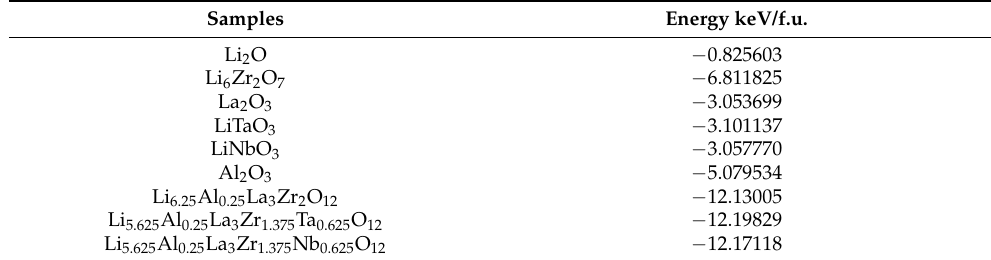
Figure 5. Comparison of EIS profiles of Li symmetric cells with ( a ) Al-LLZO and ( b ) Al-LLZTO at 55 ◦ C. ( c ) The interfacial resistances of the Li/LLZO/Li symmetric cells with Al-LLZO, Al-LLZTO, and Al-LLZNO. The galvanostatic cycles of Li symmetric cells at a current density of 0.2 mA · cm − 2 and a capacity of 0.1 mA · h · cm − 2 for as-prepared and 24 h air-exposed ( d ) Al-LLZO, ( e ) Al-LLZTO, and ( f ) Al-LLZNO. Table 1. The energies of reactants and products.